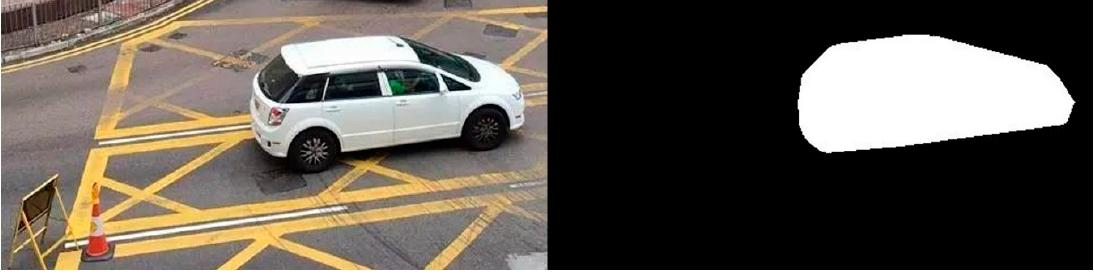
Figure 4. An example of noise reduction.